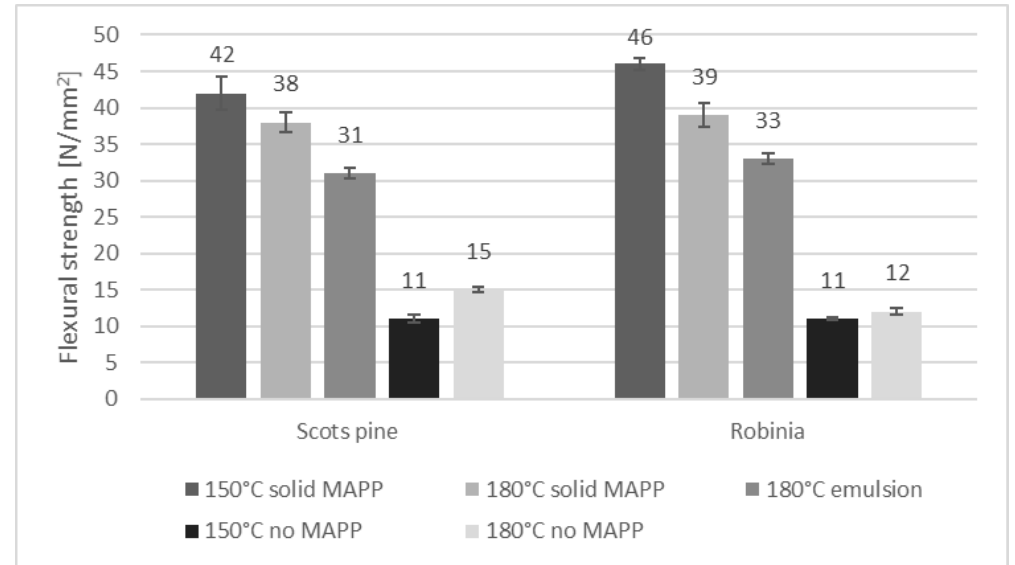
Figure 1. Flexural strength of composites with TMP based on Scots pine or Robinia. For comparison, flexural strength of composites with wood flour (softwood) was 50 N/mm 2 including MAPP (solid) and 16 N/mm 2 excluding MAPP.